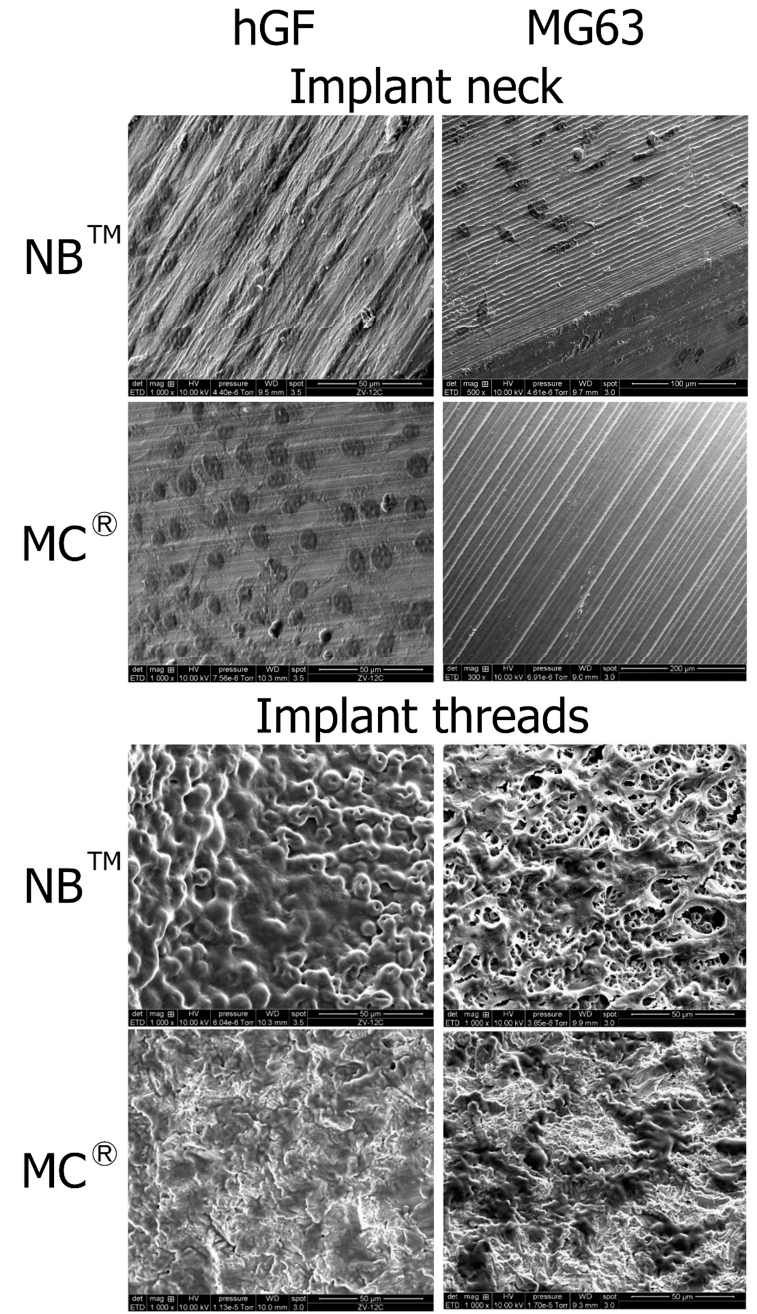
Figure 7. Cell adhesion observed by SEM at the implant necks and implant threads. hGF and MG63 cells were in direct contact with NB™ and MC ® . Scale bars = 50 µm, 100 µm and 200 µm.